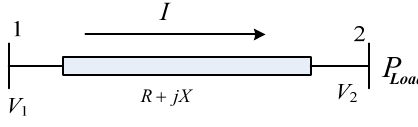
Figure 1. Diagram of a single